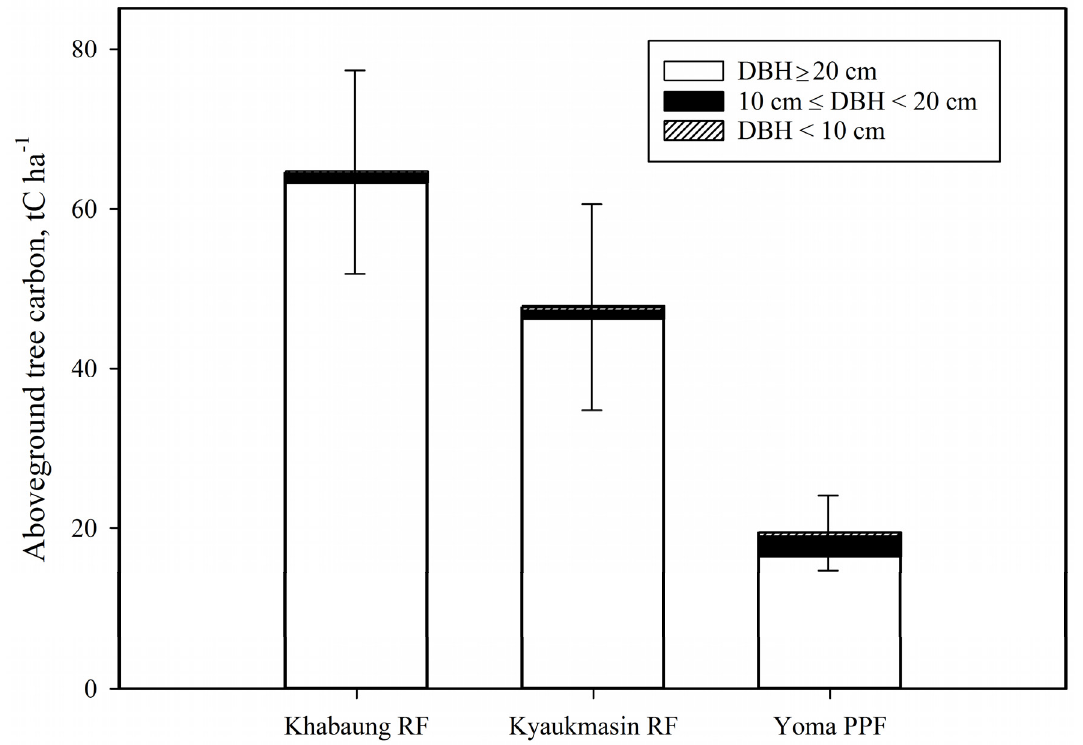
Figure 4. Aboveground tree carbon at the Khabaung Reserved Forest, Kyaukmasin Reserved Forest, and Yoma Protected Public Forest study sites. Error bars are 95% confidence intervals .